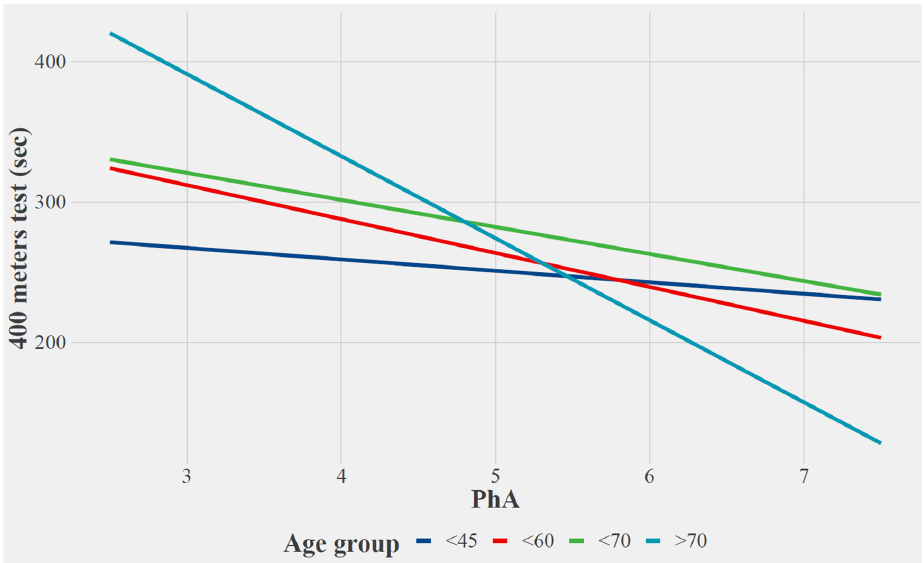
Figure 2. Estimated relationship between PhA and 400 mWT by age group